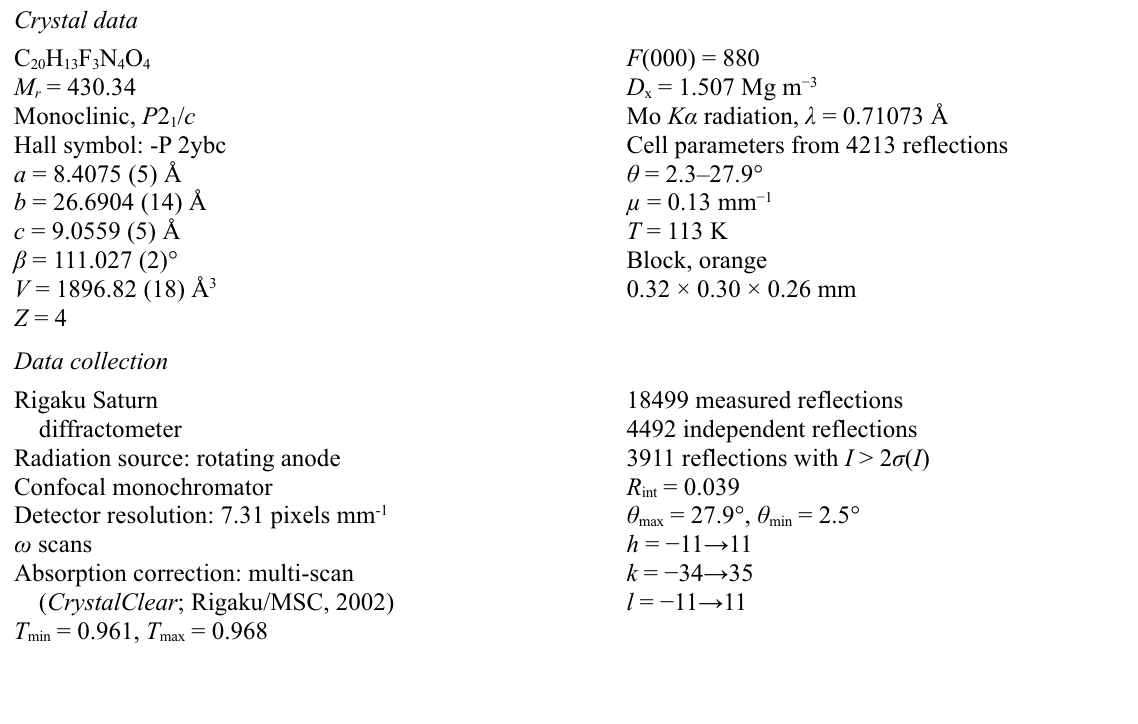
The packing diagram of the title compound. Intermolecular hydrogen bonds are shown as dashed lines. Ethyl 4-(4-nitrophenyl)-2-(trifluoromethyl)pyrimido[1,2- a ]benzimidazole-